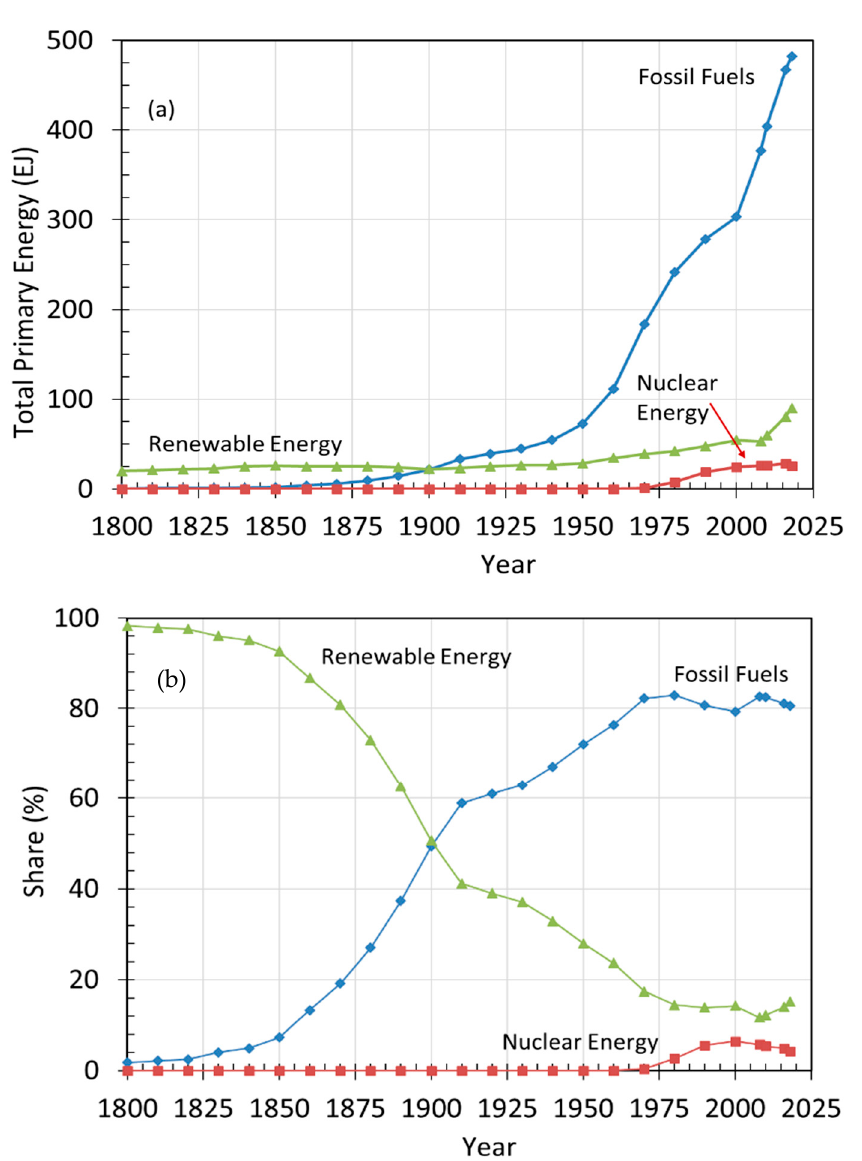
Figure 1. Global primary energy use by energy type, 1800–2018: ( a ) in EJ; ( b ) Share %. Sources: 1,2,5,6.